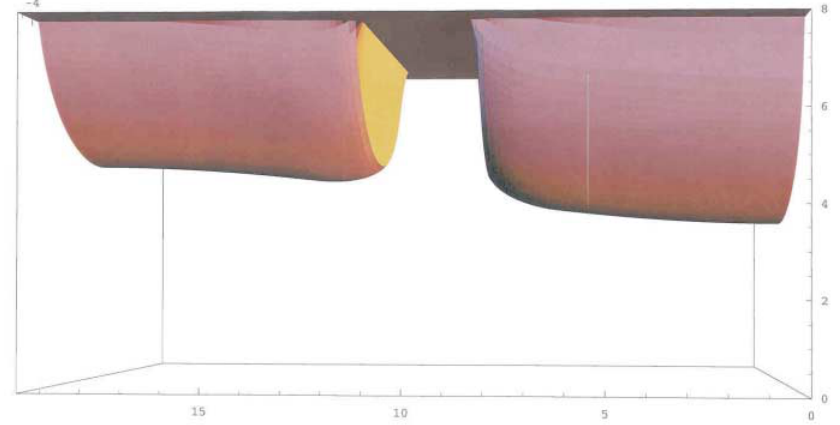
FIG. 5. (Color) Vane profile with coupling gap. An elliptical curvature avoids a field enhancement without impairing the focusing forces significantly.